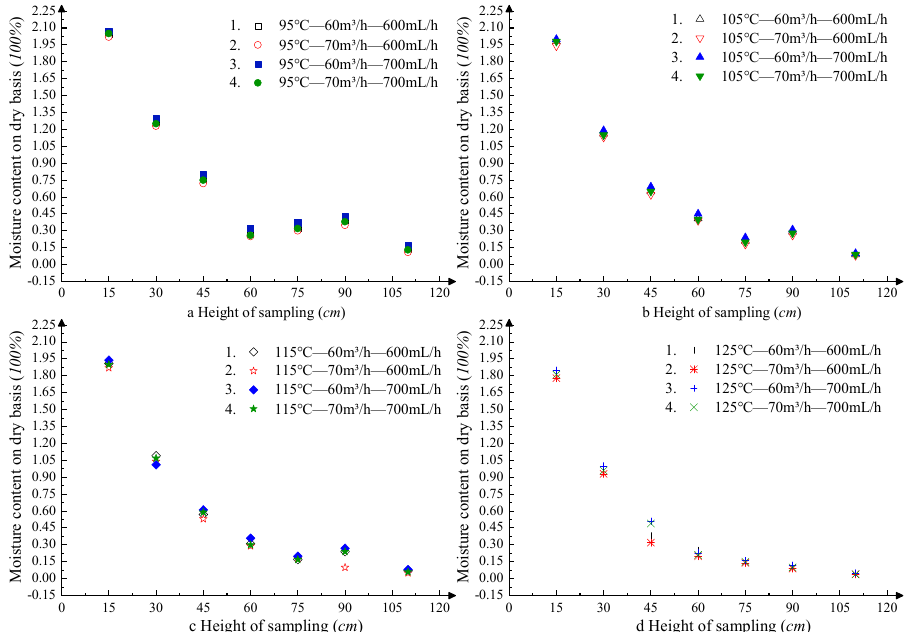
Figure 7. Moisture of yeast in each sampling cup under different test parameters.